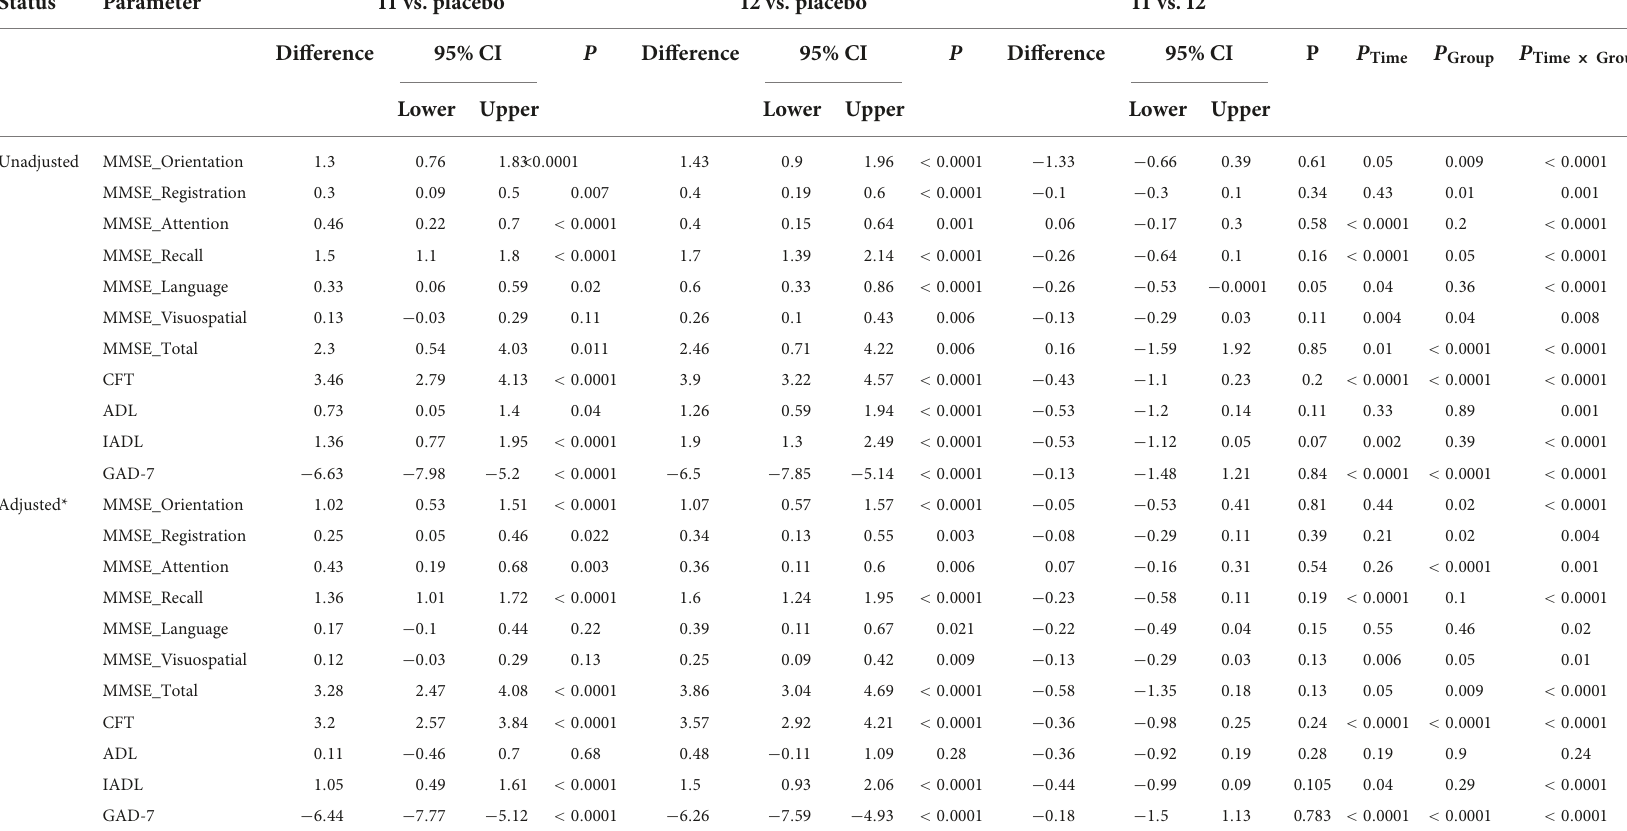
TABLE 3 Treatment effect of probiotic supplements on MMSE, CFT, ADL, IADL, and GAD.